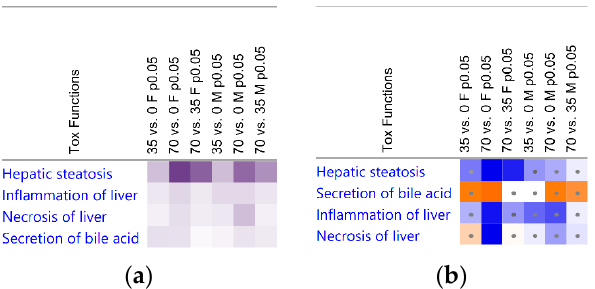
Figure 4. Heatmap of the Hepatotoxicity Functions based on the differentially expressed gene patterns in the liver tissue samples of female (F) and male (M) mice. Functions were organized by the collective score values. Pairwise comparisons are indicated in the column headers with first three from the left for the females and the other three columns for the males. Significant functions were filtered by B-H p -values < 0.1 and | z |-scores > 2, ( a ) shades of purple indicate − log B-H p -values ; ( b ) blue shades indicates inhibition, orange—activation, for 70% diet group in at least one sex cohort. Dots denote insignificant | z |-scores <